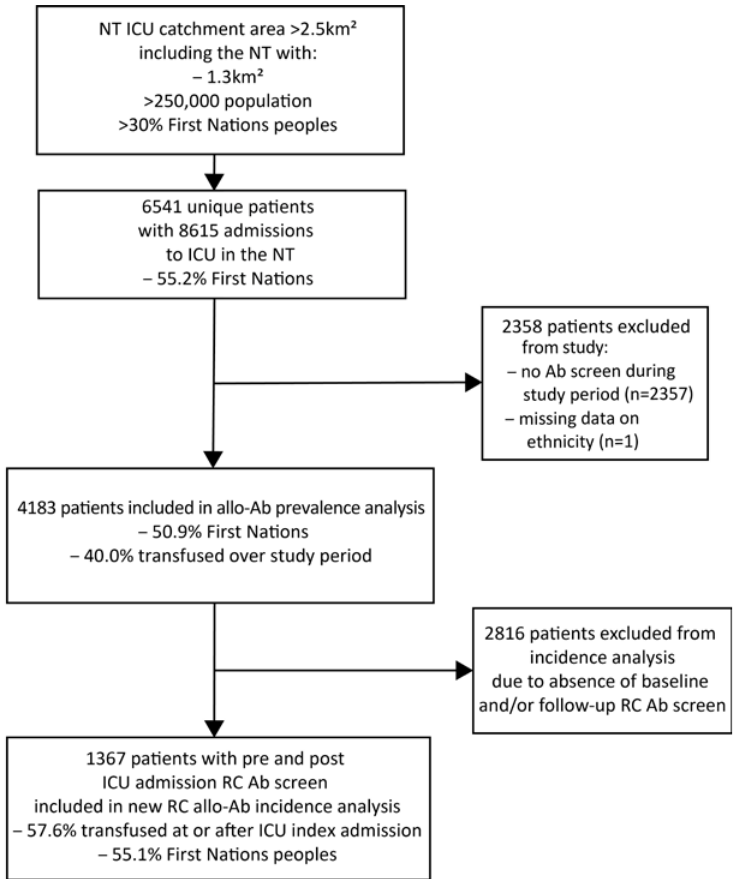
Figure 1. Study flow diagram, Northern Territory (NT) intensive care unit (ICU) patient admission retrospective cohort, 2015–2019 inclusive. Ab: antibody; RC: red cell.